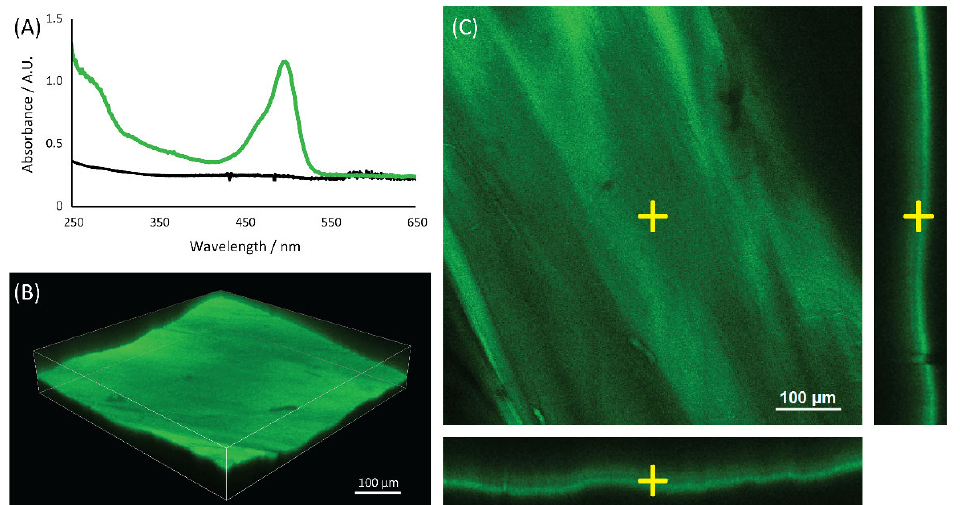
Figure 2. UV ‐ Vis spectroscopic analyses of the matrix. ( A ) UV ‐ Vis spectra of the blank control (black line) and the WGA ‐ FITC treated (green line) chitin samples. The confocal analyses of a wet WGA ‐ FITC treated sample are shown, and both the ( B ) 3D model and ( C ) sections along different planes are reported.